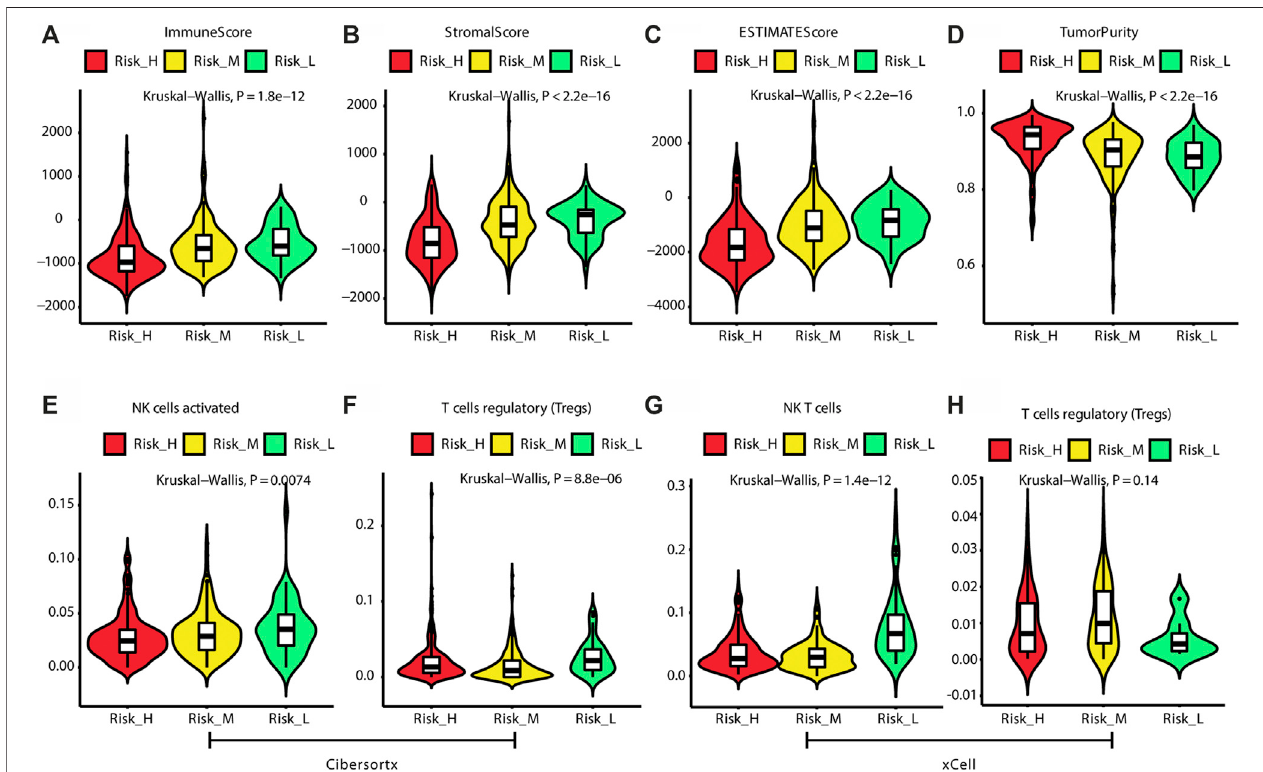
FIGURE4| Thedifferenceoftumormicroenvironmentamongthreesubtypes. (A) TheviolinplotshowsimmunescoreisthelowestinRisk_Hsubtype. (B) Theviolin plot shows stromal score is the lowest in Risk_H subtype. (C) The violin plot shows ESTIMATE score is the lowest in Risk_H subtype. (D) The violin plot shows tumor purity is the highest in Risk_H subtype. (E) The violin plot shows content of NK cells activated is the lowest in Risk_H subtype. (F) The violin plot shows content of Treg cellsisthelowestinRisk_Hsubtype. (G) TheviolinplotshowscontentofNKTcellsisthelowestinRisk_Hsubtype. (H) TheviolinplotshowscontentofTregcellsis not signi fi cantly different among subtypes. ( p < 0.05 is de fi ned as statistically signi fi